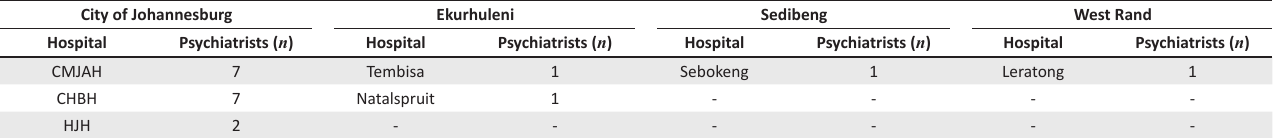
FIGURE 2: Residential beds and day care places/100 000 population for adult mental health care users in comparison to norms of the Mental Health TABLE 4: Distribution of general hospital-based psychiatrists.